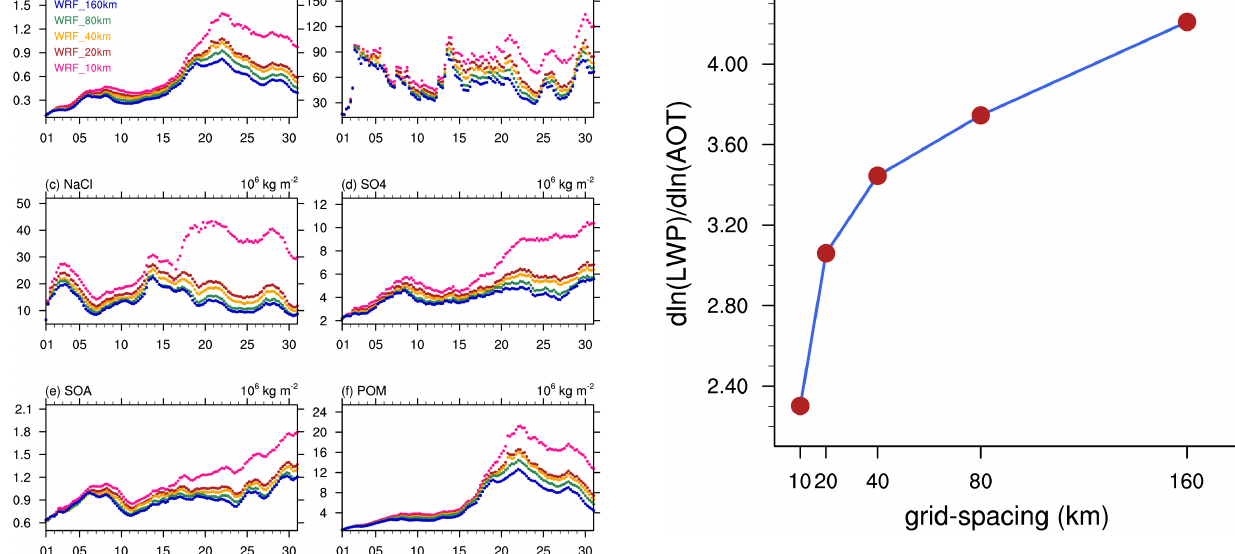
Fig. 10. Cloud susceptibility to aerosol forcing as a function of model horizontal grid